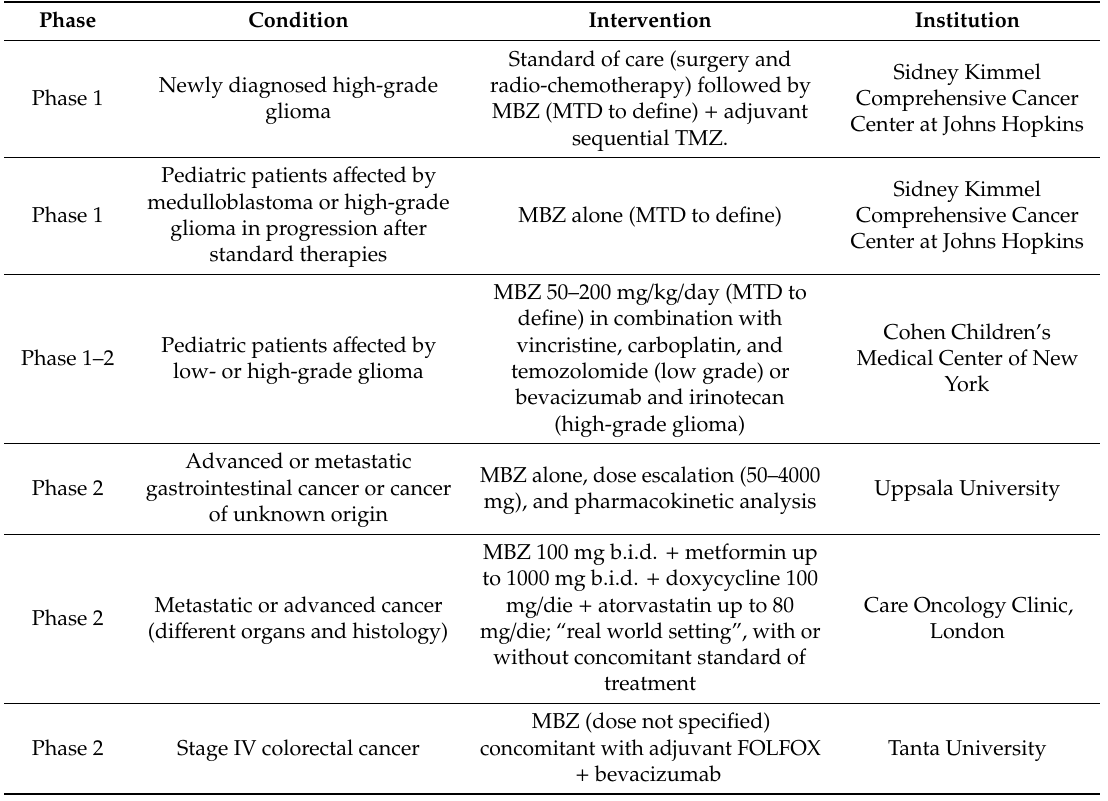
Table 2. Ongoing studies registered at Clinicaltrials.Gov investigating MBZ as a repurposed drug in oncology. MTD = maximum tolerated